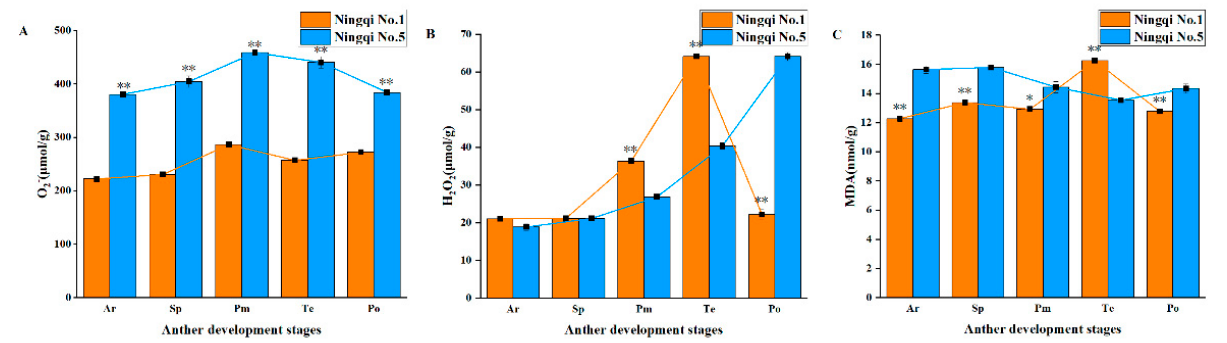
Figure 5. Contents of O 2 − , H 2 O 2 , and MDA during the pollen grain development of Ningqi No. 5 and Ningqi No. 1. ( A ) O 2 − content; ( B ) H 2 O 2 content; ( C ) MDA content. Ar, archesporial cell stage; Sp, sporogenous cell stage; Pm, pollen mother cell stage; Te, tetrad stage; Po, pollen grain stage. *, ** represents p < 0.05 and p < 0.01, respectively.